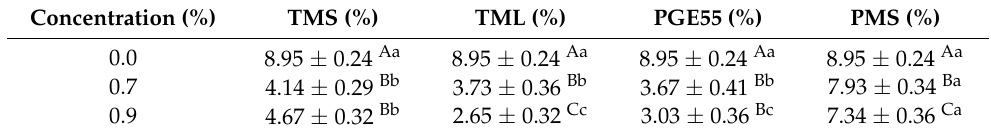
Table 2. The effect of the concentrations of PGEs on partial agglomeration